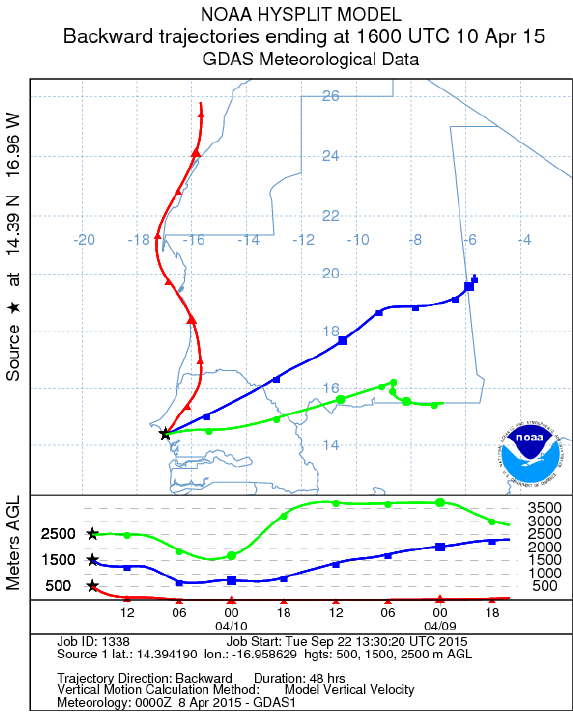
Figure 12. Backward trajectories of air masses for an event over the Dakar site on 10 April 2015.